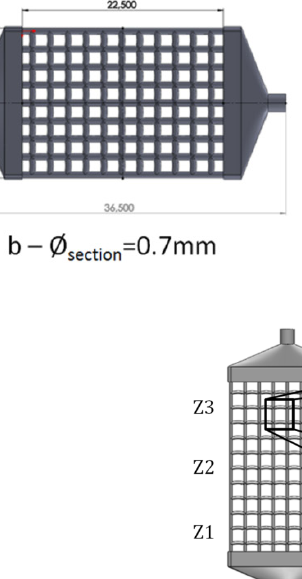
Figure 2. Spiral model (H=8.0mm; Revolutions=4; Ø